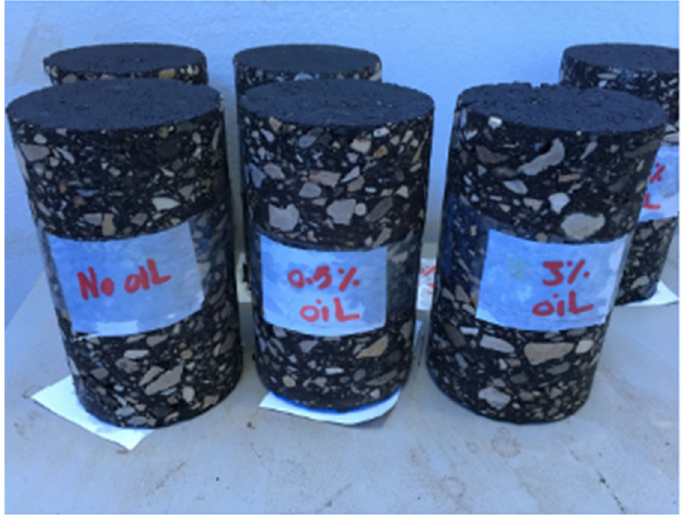
Figure 4. Samples for the E* test after cutting and coring.